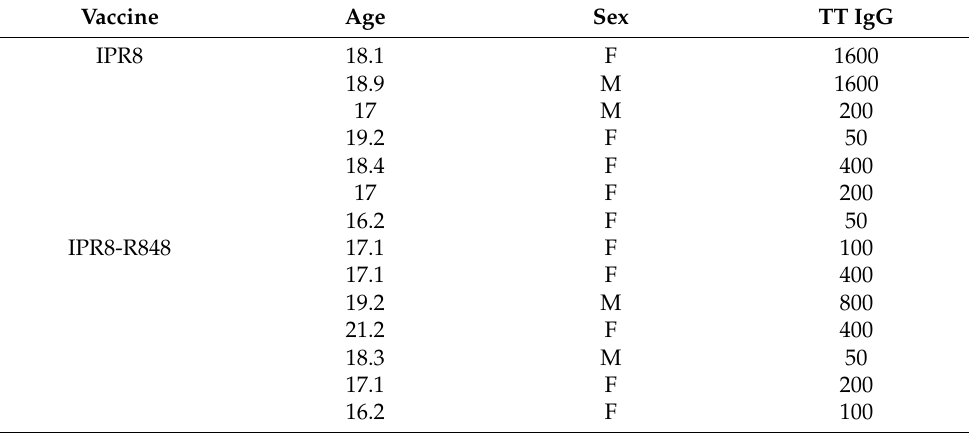
Table 1. Characteristics and threshold titer of vaccine-specific IgG titer prior to vaccination.